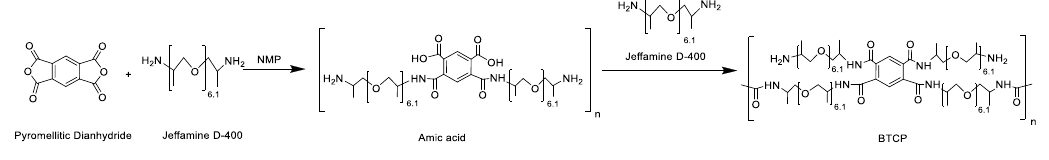
Figure 2. Reaction scheme for the synthesis of BTCP.